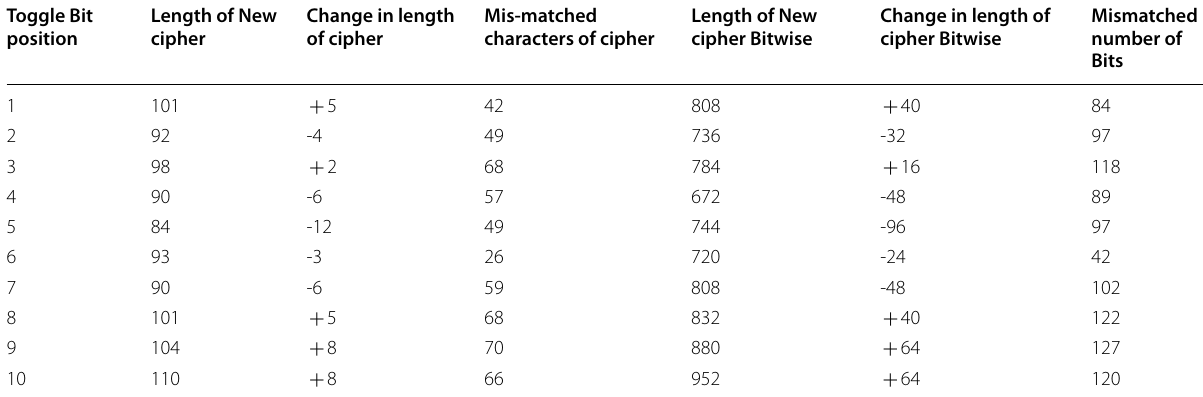
Table 4 Differential cryptanalysis Toggle Bit position